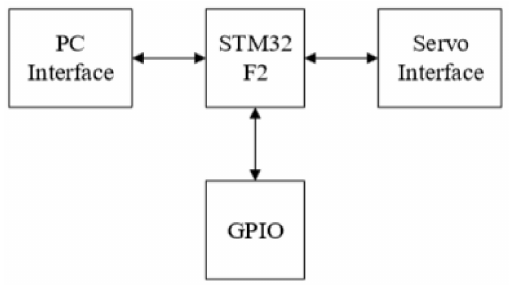
Figure 12. Block diagram of the communication interface.